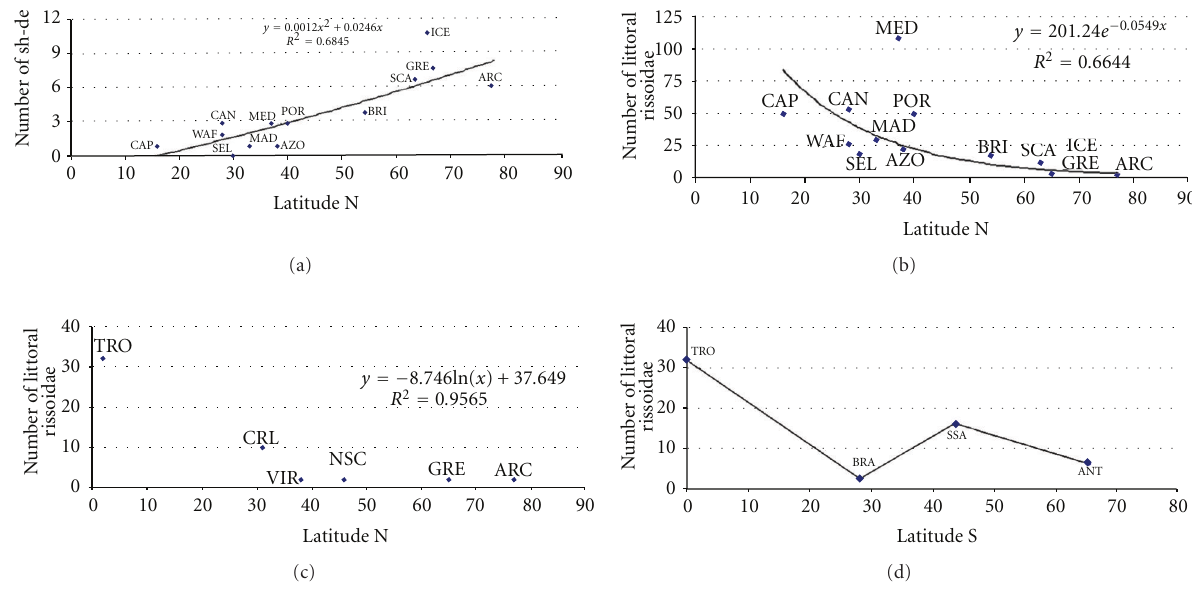
Figure 9: Relation between (a) number of rissoids with large bathymetrical range (#sh - de: shallow - deep) and latitude in the eastern Atlantic; (b) number of littoral rissoids and latitude in the eastern Atlantic; (c) number of littoral rissoids and latitude in the western Atlantic; (d) number of littoral rissoids and latitude in the western